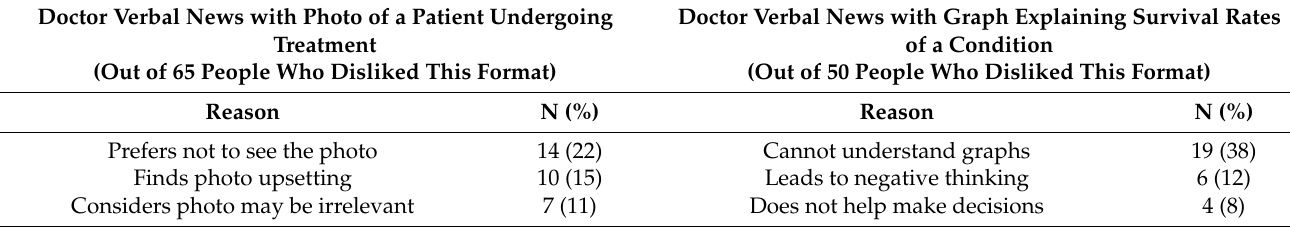
Table 5. Reasons for disliking the top communication formats for prognostic